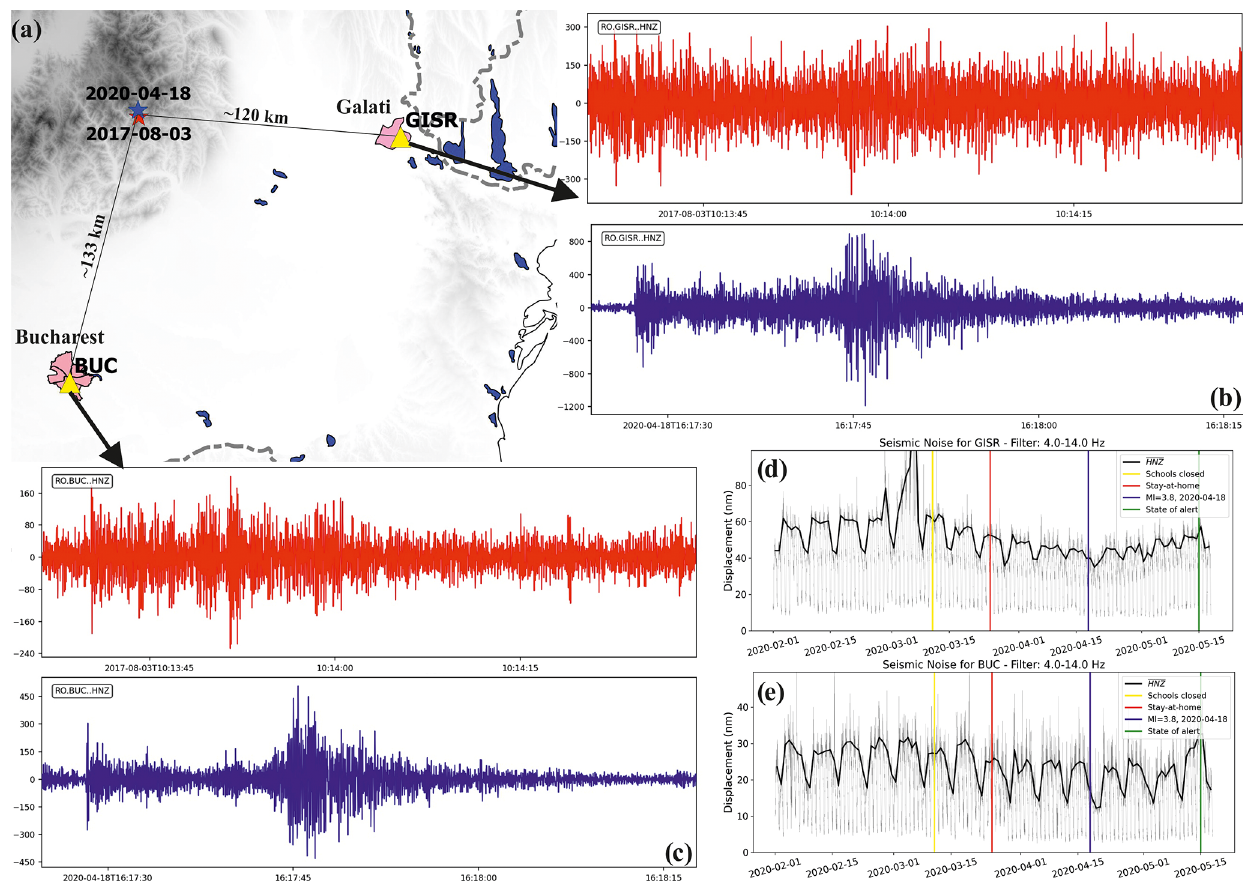
Figure 13. Illustration of the increased earthquake detection capability at two stations of RSN: (a) map showing the epicenter locations of two intermediate-depth Vrancea earthquakes (3 August 2017, 13:13:16 local time, ML = 3.8, H = 117km, shown as a red star; 18 April 2020, 19:17:03 local time, ML = 3.8, H = 118km, shown as a blue star) and the location of the two accelerometers in Bucharest (BUC) and Galati (GISR). (b, c) Waveforms recorded by the two stations (red trace for the event before the lockdown and blue trace for the event within the lockdown); (d, e) Temporal changes in seismic noise at the stations GISR and BUC.